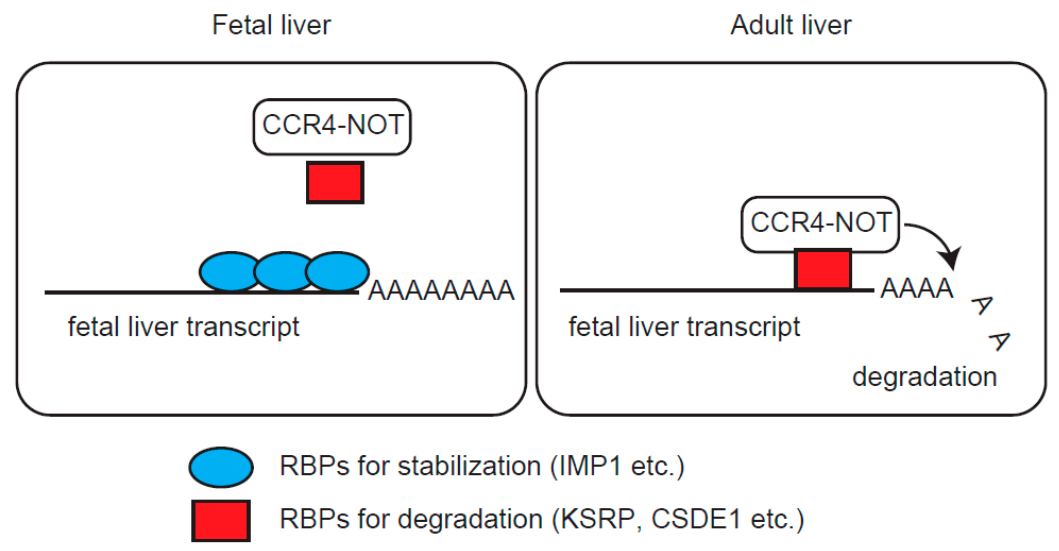
Figure 6. Schematic model of the postnatal decrease of fetal liver transcripts through mRNA decay. In fetal liver, RBPs for RNA stabilization (blue), such as IMP1 protect fetal liver transcripts from degradation. Expression of stabilization-related RBPs decreases during liver maturation, and instead different RBPs (red) that associate with the CCR4-NOT complex, bind to fetal liver transcripts. Consequently, fetal liver transcripts undergo CCR4-NOT complex-mediated degradation.